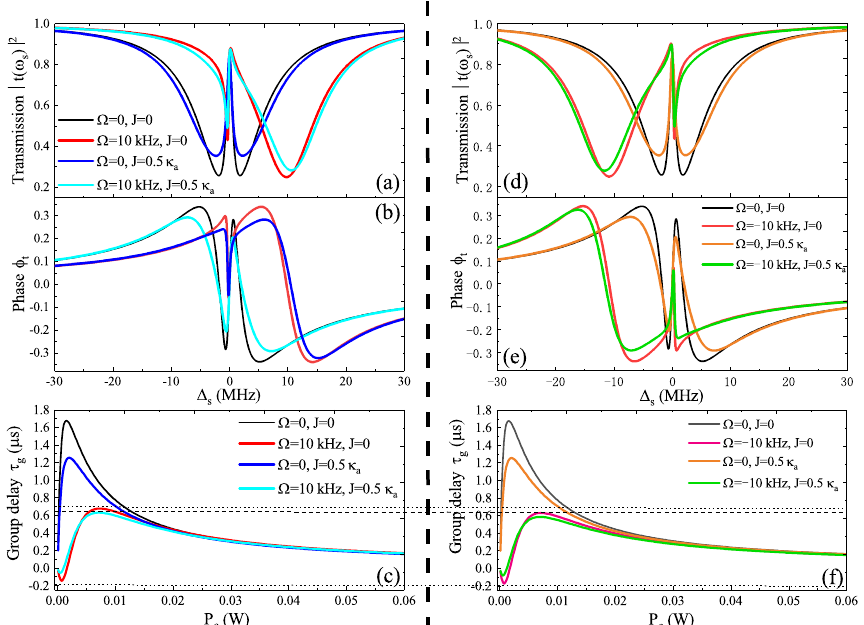
Figure 2. ( a , b ) The transmission and phase φ t versus ∆ s for different parameter regimes under the condition of Ω > 0. ( c ) The group delay τ g versus P c for different parameter regimes corresponding to ( a , b ). ( d , e ) The probe transmission and the phase φ t versus ∆ s for different parameter regimes in the case of Ω < 0. ( f ) The group delay τ g versus P c for several different parameters corresponding to ( d , e